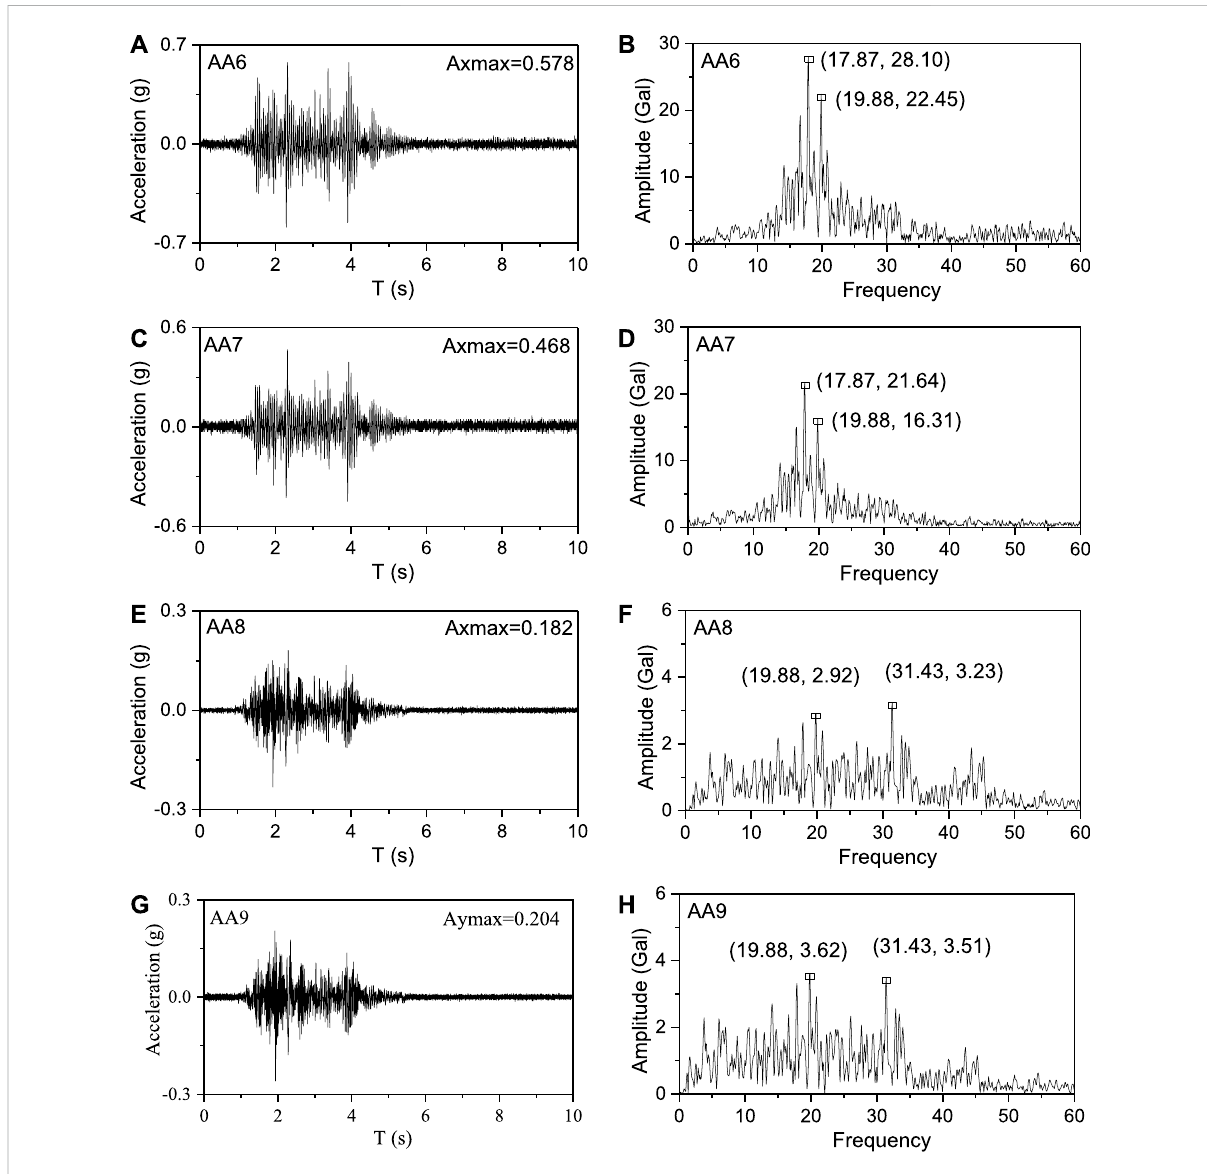
FIGURE 7 Acceleration time history and Fourier spectrum of measured points in section ΙΙ ’ under 0.15 g earthquake excitation: (A) acceleration history of AA6 point; (B) Fourier spectrum of AA6 point; (C) acceleration history of AA7 point; (D) Fourier spectrum of AA7 point; (E) acceleration history of AA8 point; (F) Fourier spectrum of AA8 point; (G) acceleration history of AA9 point; (H) Fourier spectrum of AA9